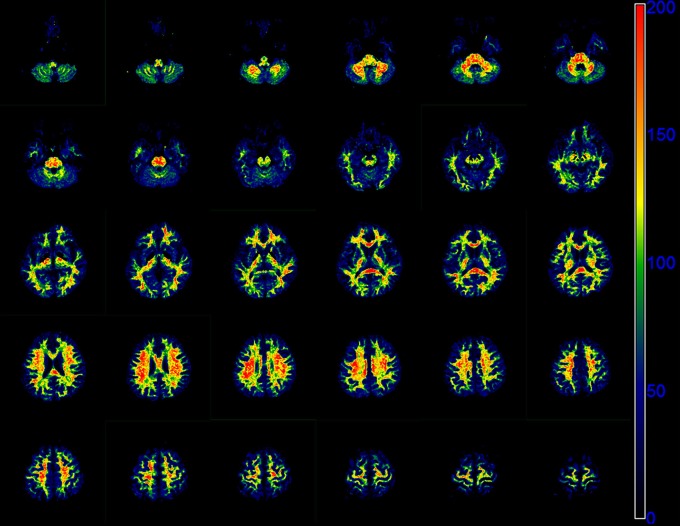
Sequential 30 slices of the f0 maps of one volunteer derived by the modified tri-exponential model. The f0 maps are displayed from the top left. The unit is ‰.